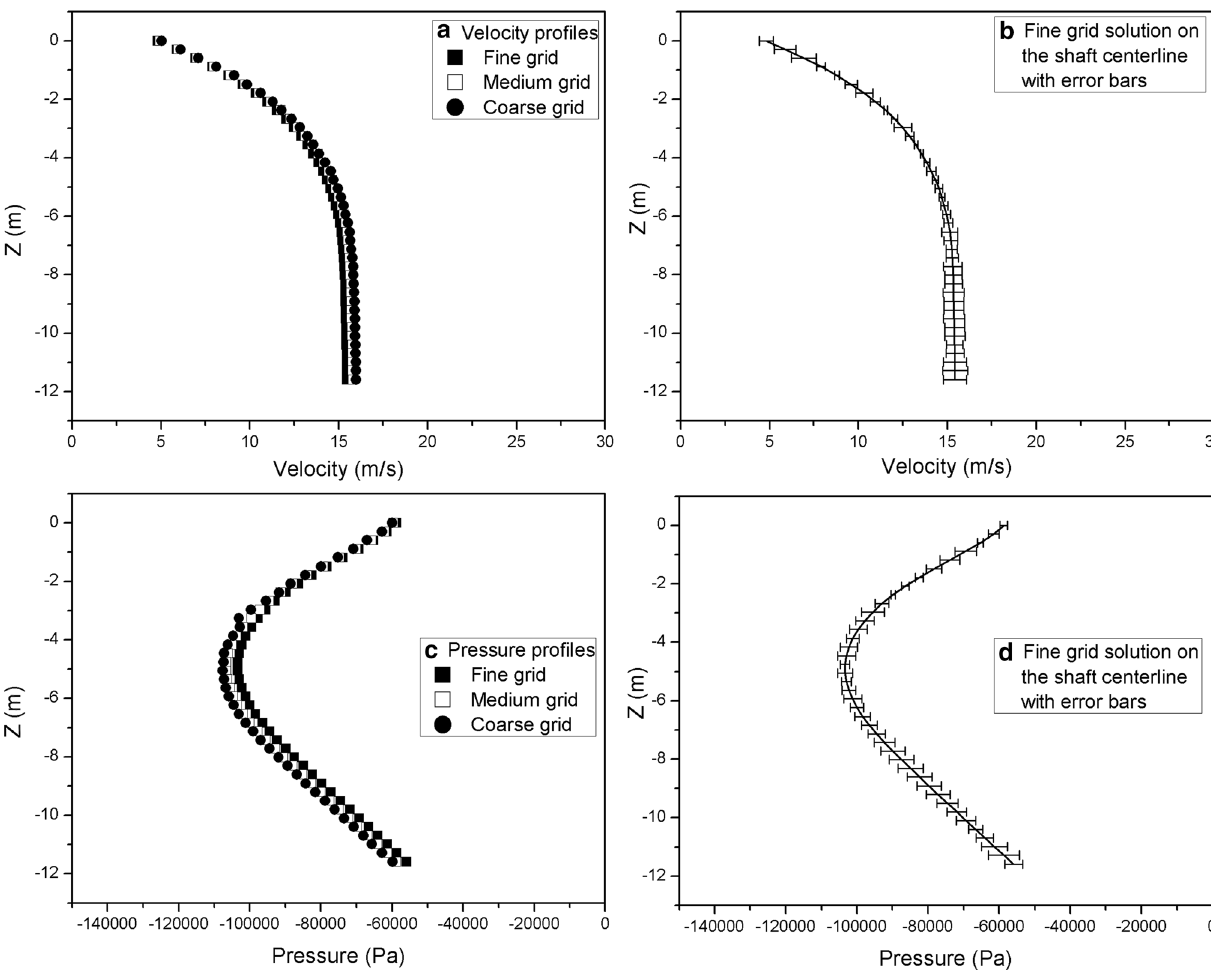
Fig. 4 Different grid solutions with discretization error